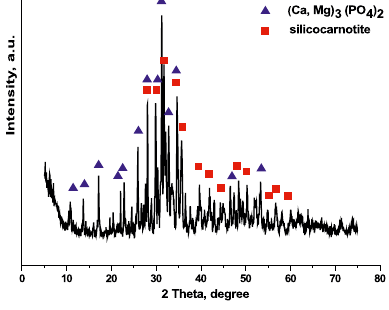
Figure 2. XRD of Ca-2 sample after thermal treatment at 1200 o C/2